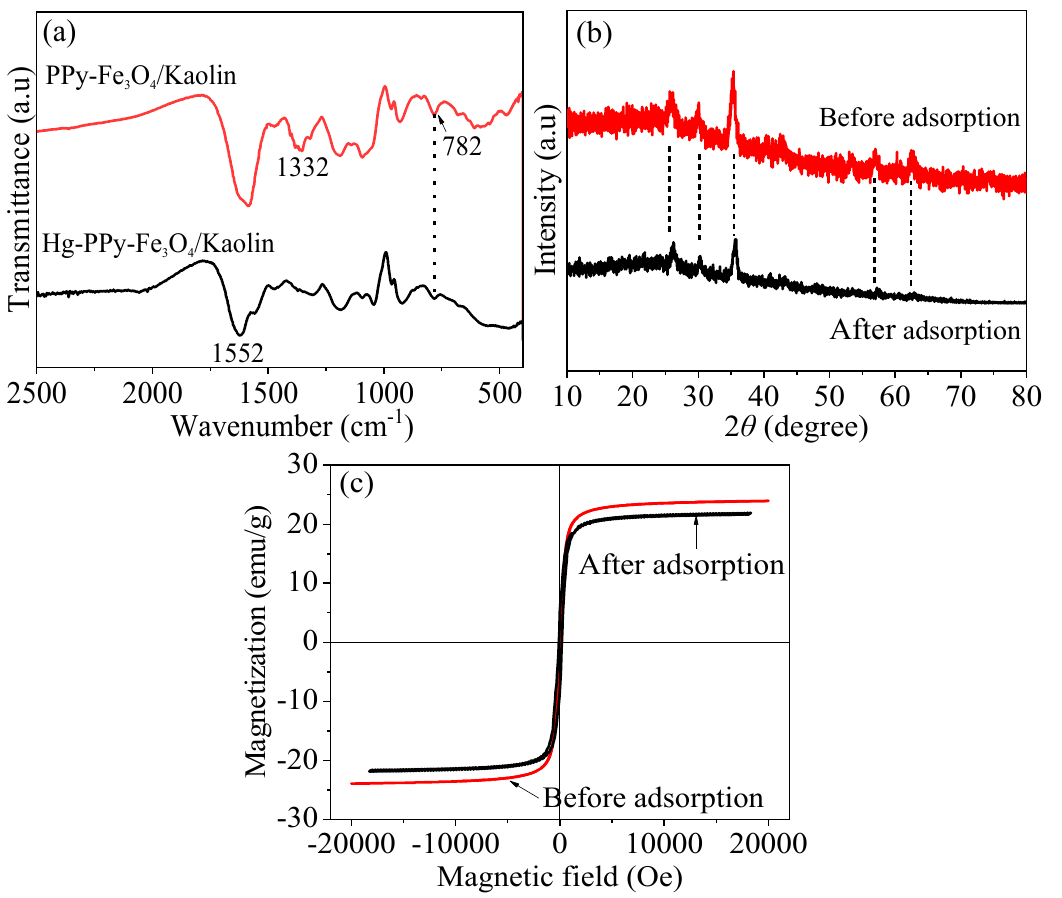
Figure 16. Spectra before and after adsorption with PPy-Fe 3 O 4 /Kaolin: ( a ) FT-IR, ( b ) XRD and ( c ) VSM.